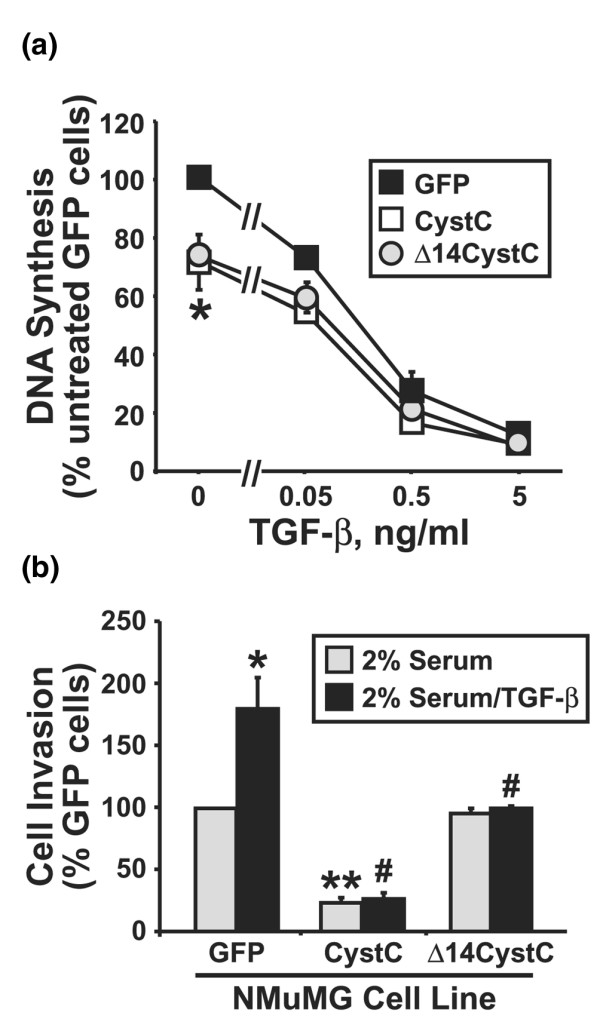
CystC and Δ14CystC inhibit NMuMG cell proliferation and invasion. (a) Control, CystC-expressing, or Δ14CystC-expressing NMuMG cells were incubated with increasing concentrations of transforming growth factor-β1 (TGF-β1; from 0 to 5 ng/ml) for 48 hours. Cellular DNA was radiolabeled with [3H]thymidine and quantified by scintillation counting. Data are means ± SEM for two independent experiments presented as the percentage [3H]thymidine incorporation normalized to untreated control cells. CystC and Δ14CystC both significantly decreased DNA synthesis in resting NMuMG cells (*P < 0.05; Student's t-test). (b) Control, CystC-expressing, and Δ14CystC-expressing NMuMG cells were allowed to invade through Matrigel matrices in the absence or presence of TGF-β1 (5 ng/ml) for 48 hours. Values are means ± SEM for three independent experiments presented as the percentage invasion relative to GFP-expressing NMuMG cells. TGF-β1 significantly enhanced NMuMG cell invasion (*P < 0.05; Student's t-test), a response that was inhibited significantly by CystC and Δ14CystC expression (#P < 0.05; Student's t-test). CystC expression also significantly inhibited tonic NMuMG cell invasion (*P < 0.05; Student's t-test).